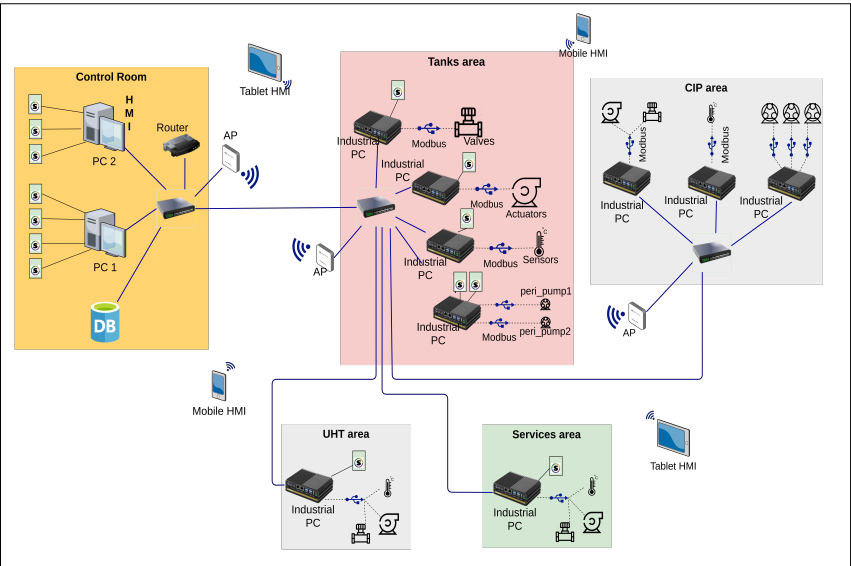
Figure 6. Embedded Personal Computer (PC) and devices platform hardware for industrial automa- tion process in Punta Delicia